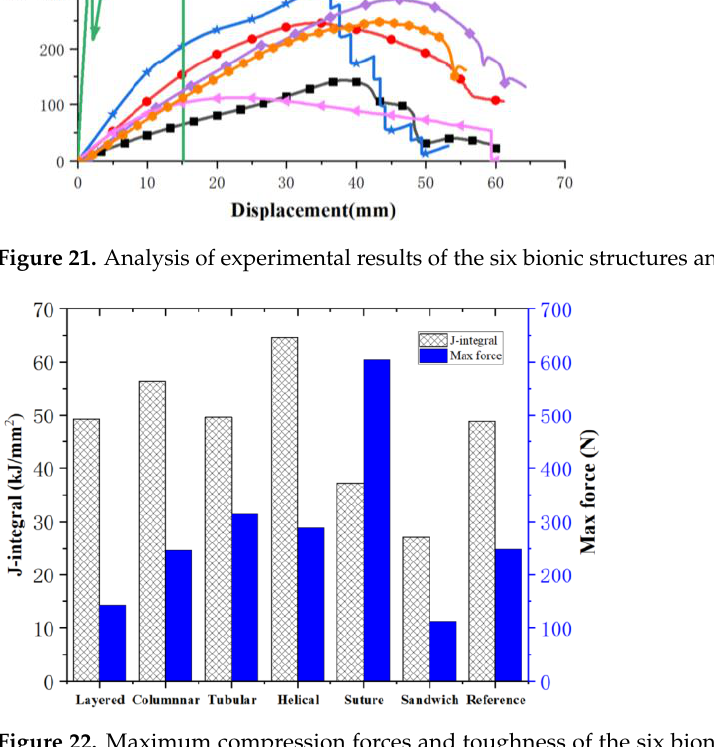
Figure 21. Analysis of experimental results of the six bionic structures and the reference model.